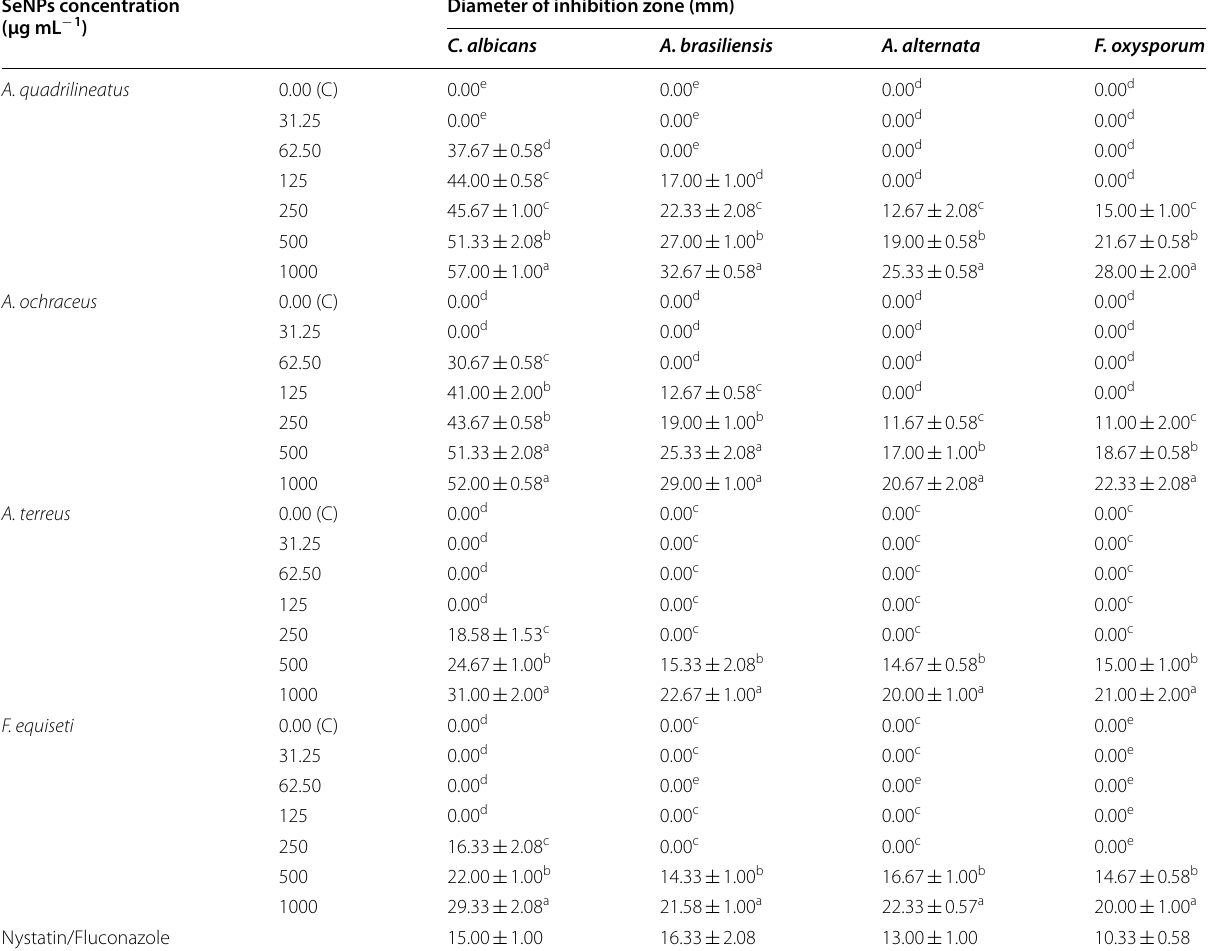
Table 3 Antifungal activity of SeNPs synthesized by A. quadrilineatus , A. ochraceus , A. terreus , and F. equiseti against different human and plant pathogenic